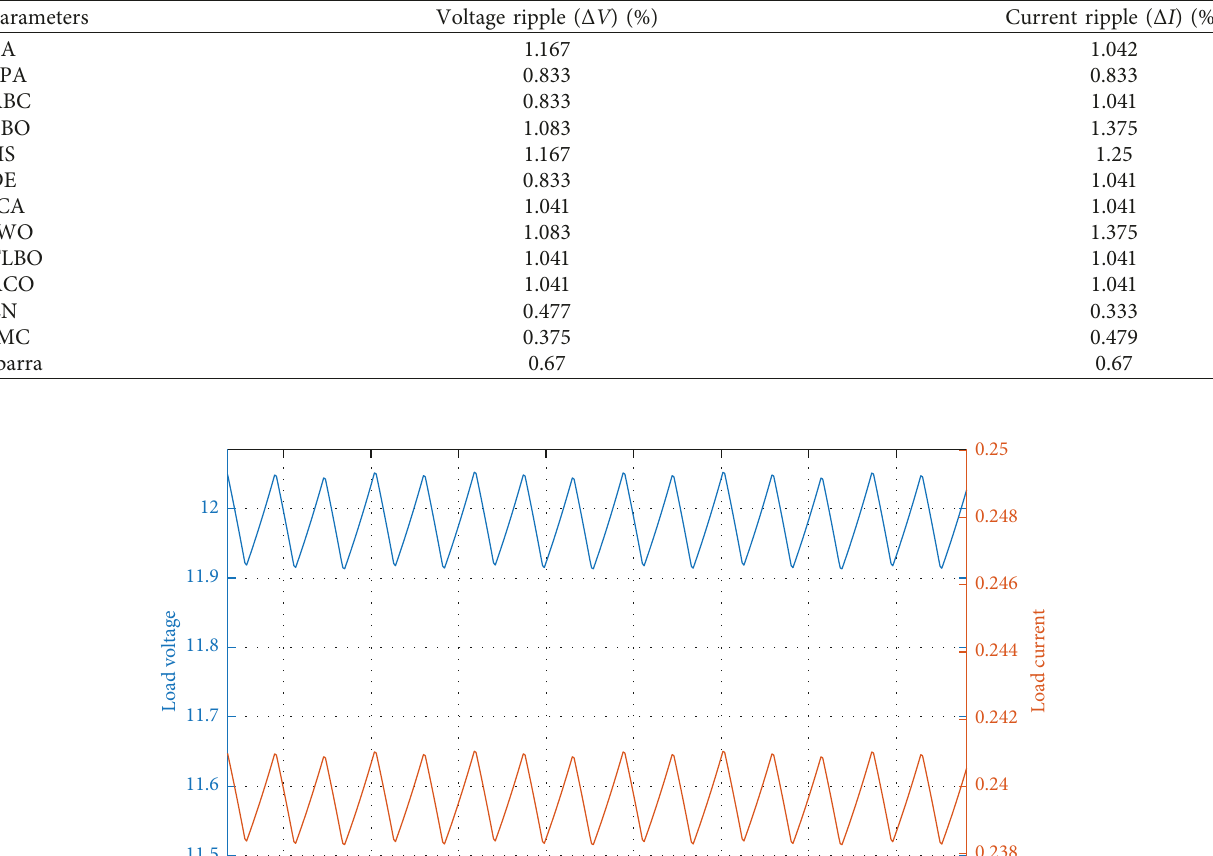
Table 3: Convertor performance parameters (variable input